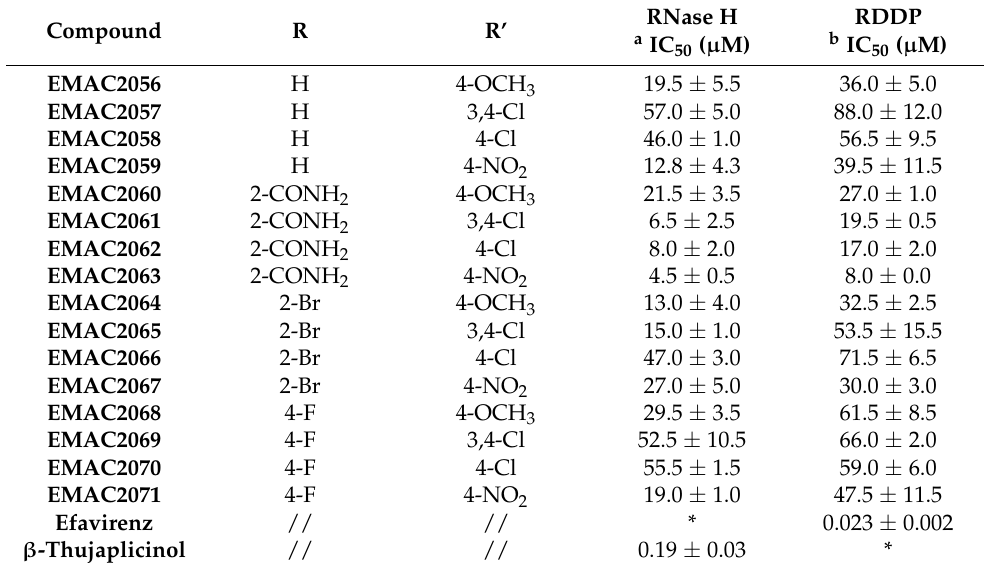
Table 1. Activity of compounds EMAC2056 – 2071 on HIV-1 RT-associated enzymatic functions RNase H and